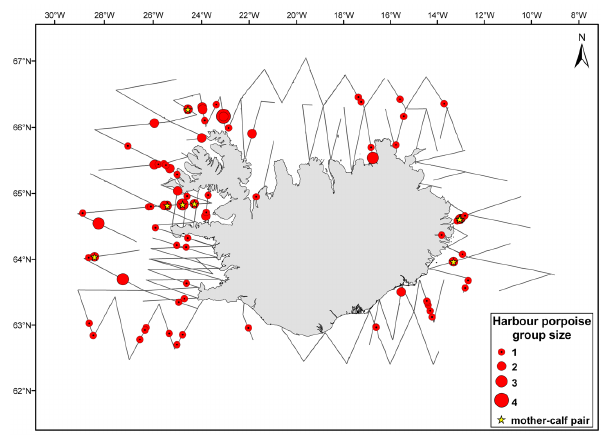
Figure 4. Realised effort (grey line) and harbour porpoise sightings during the 2007 Icelandic survey. Only sightings made by the more experienced porpoise observer are shown. (Sightings of other species are reported in Pike et al., 2020, this volume).